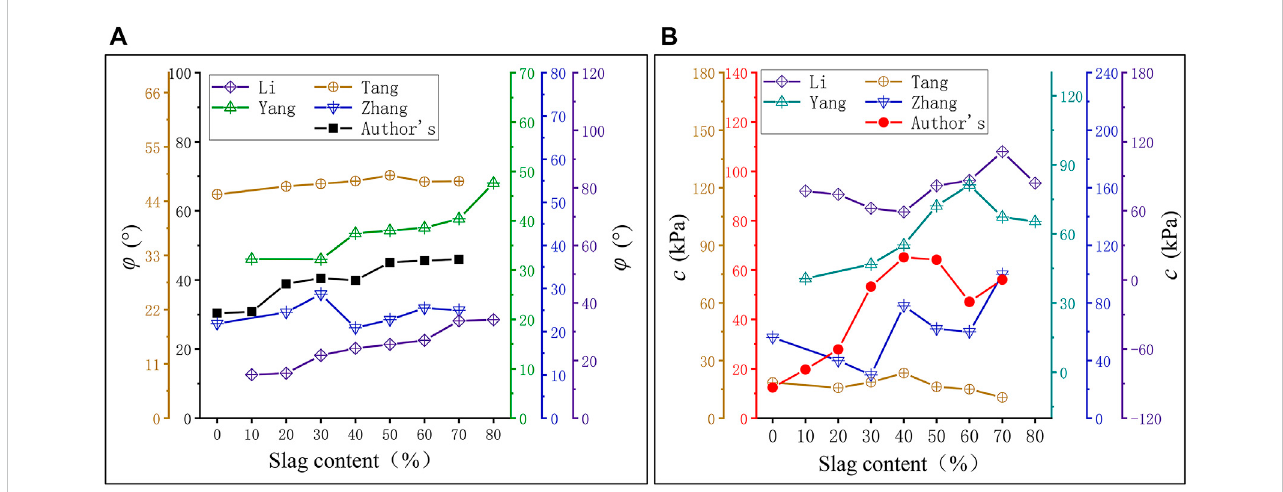
FIGURE 5 Comparison of shear strength parameters (TSM versus RSM): (A) The relationship between slag content and internal friction angle, (B) The relationship between slag content and